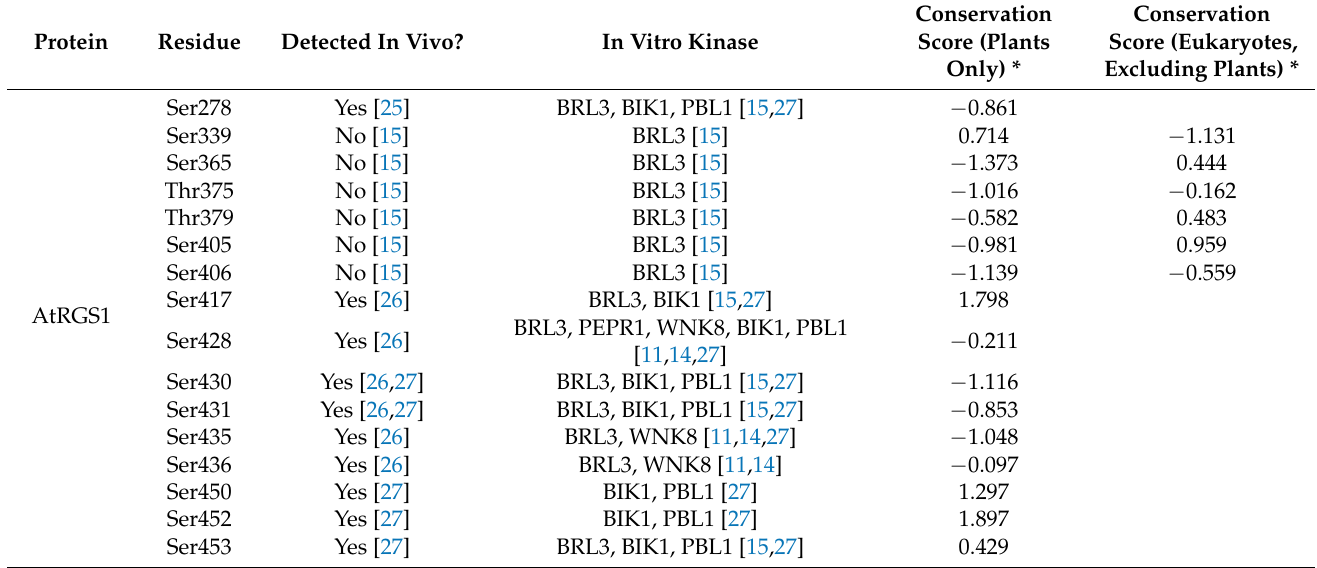
Table 1. MS-detected phosphorylation sites from the Arabidopsis G-protein